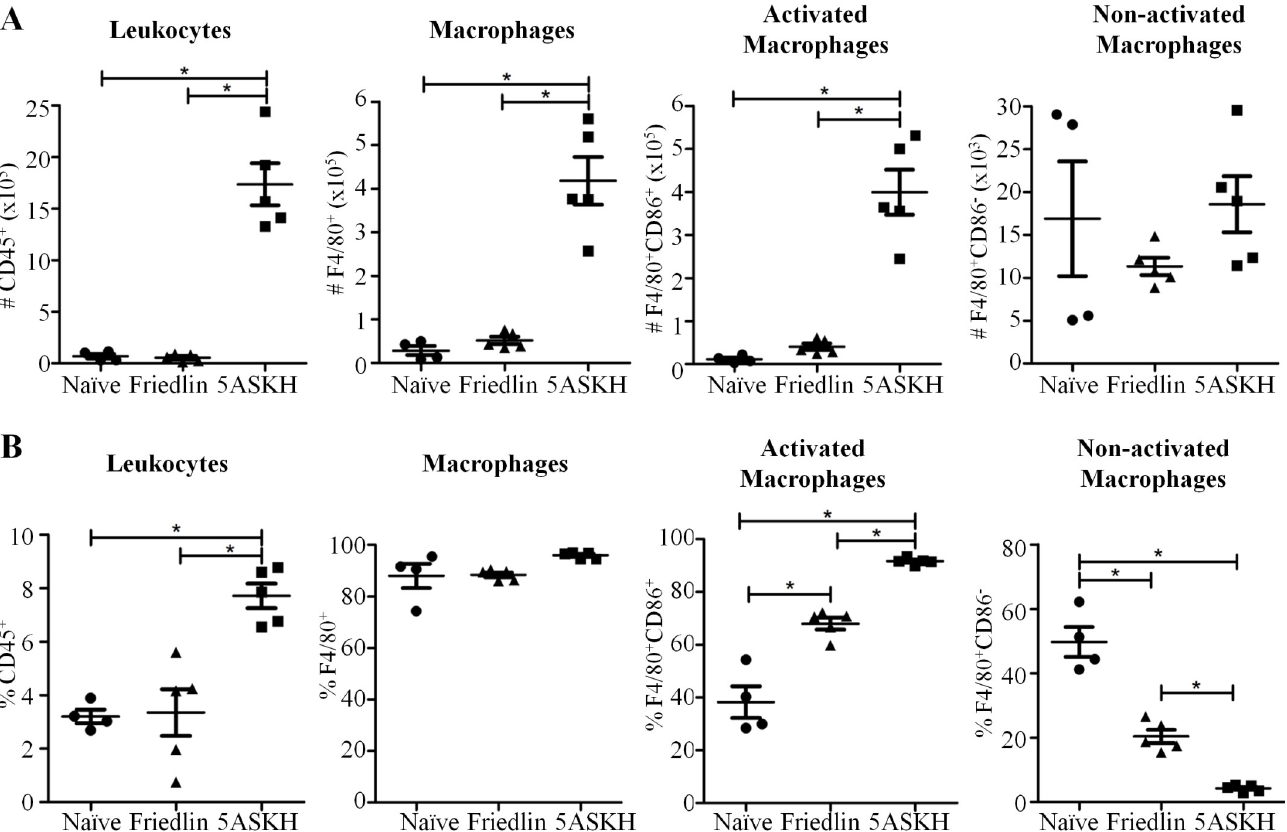
Fig 3. L . major Friedlin infection failed to augment the recruitment of macrophages in Rag2 KO mice. Rag2 KO C57BL/6 mice were infected with 5 × 10 6 stationary phase promastigotes of L . major Friedlin or 5ASKH subcutaneously into the hind footpad. At 4 weeks post-infection, cells from the mouse footpads were isolated and analyzed by flow cytometry. The total number (A) and percentages (B) of the cell populations are shown. Four–five mice per group. Data are the mean ± SEM.